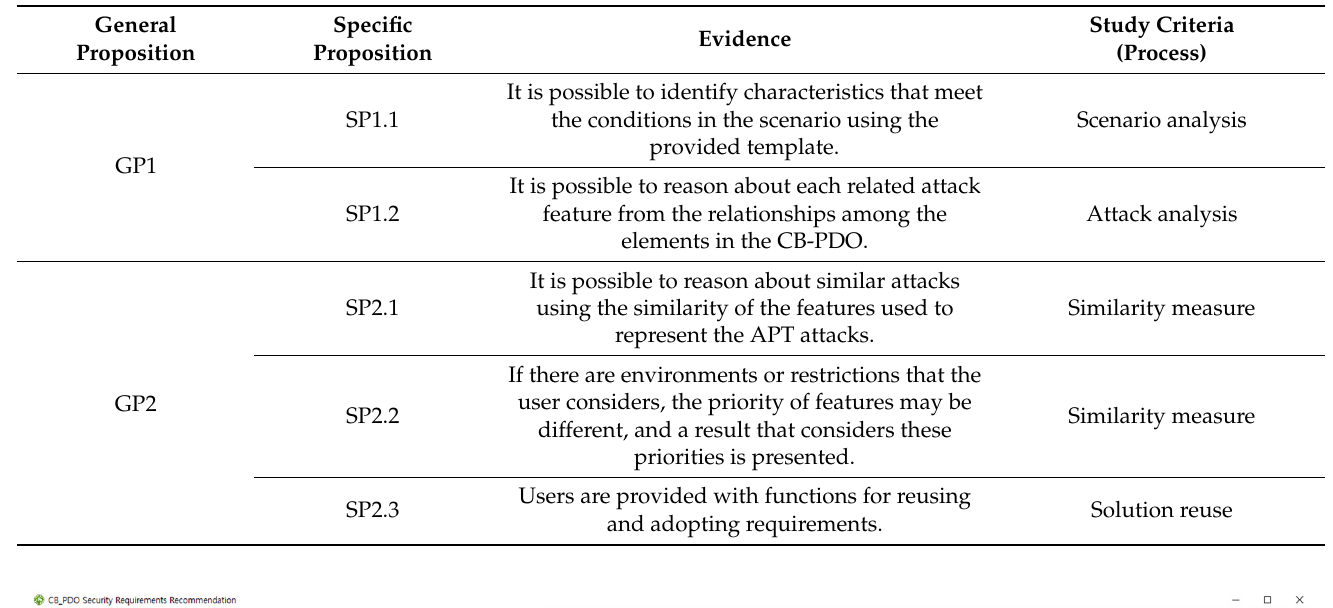
Table 6. Study propositions and analyses.